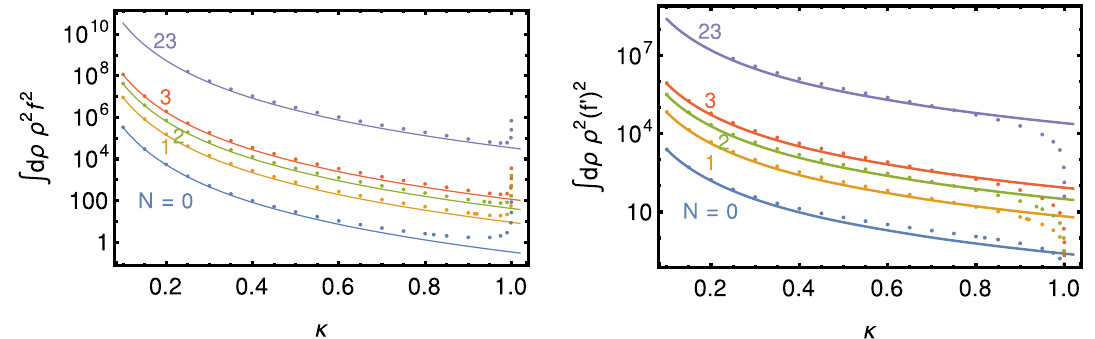
(left) and R ∗ (right) vs. κ for several N . Gray dashed lines are the approximations from Eq. (57) N , 1 N , 3